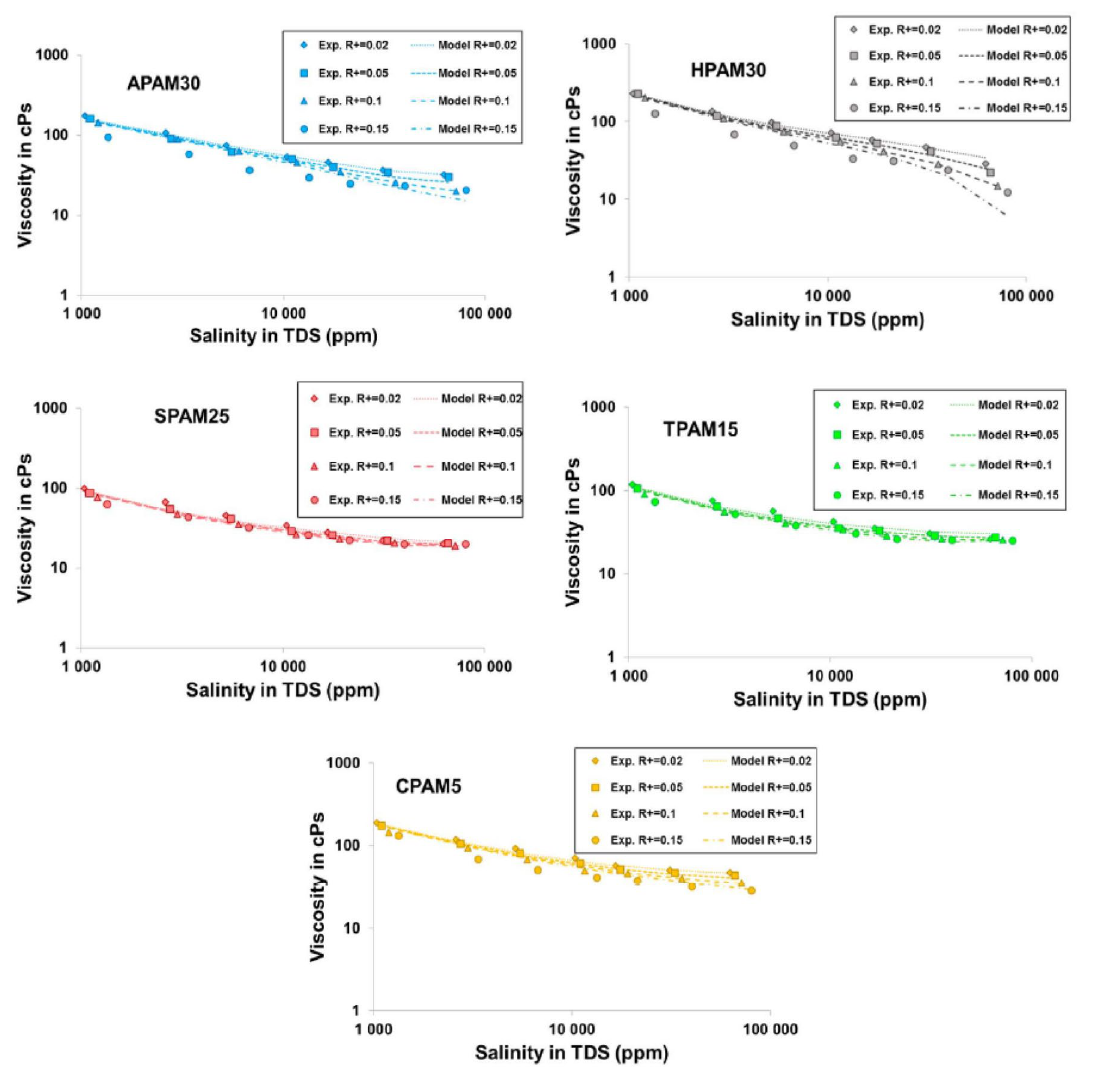
Fig. 13 Experimental data modeling using power law adjustment for 2000 ppm in alternating R+ and salinity (from Divers et al.